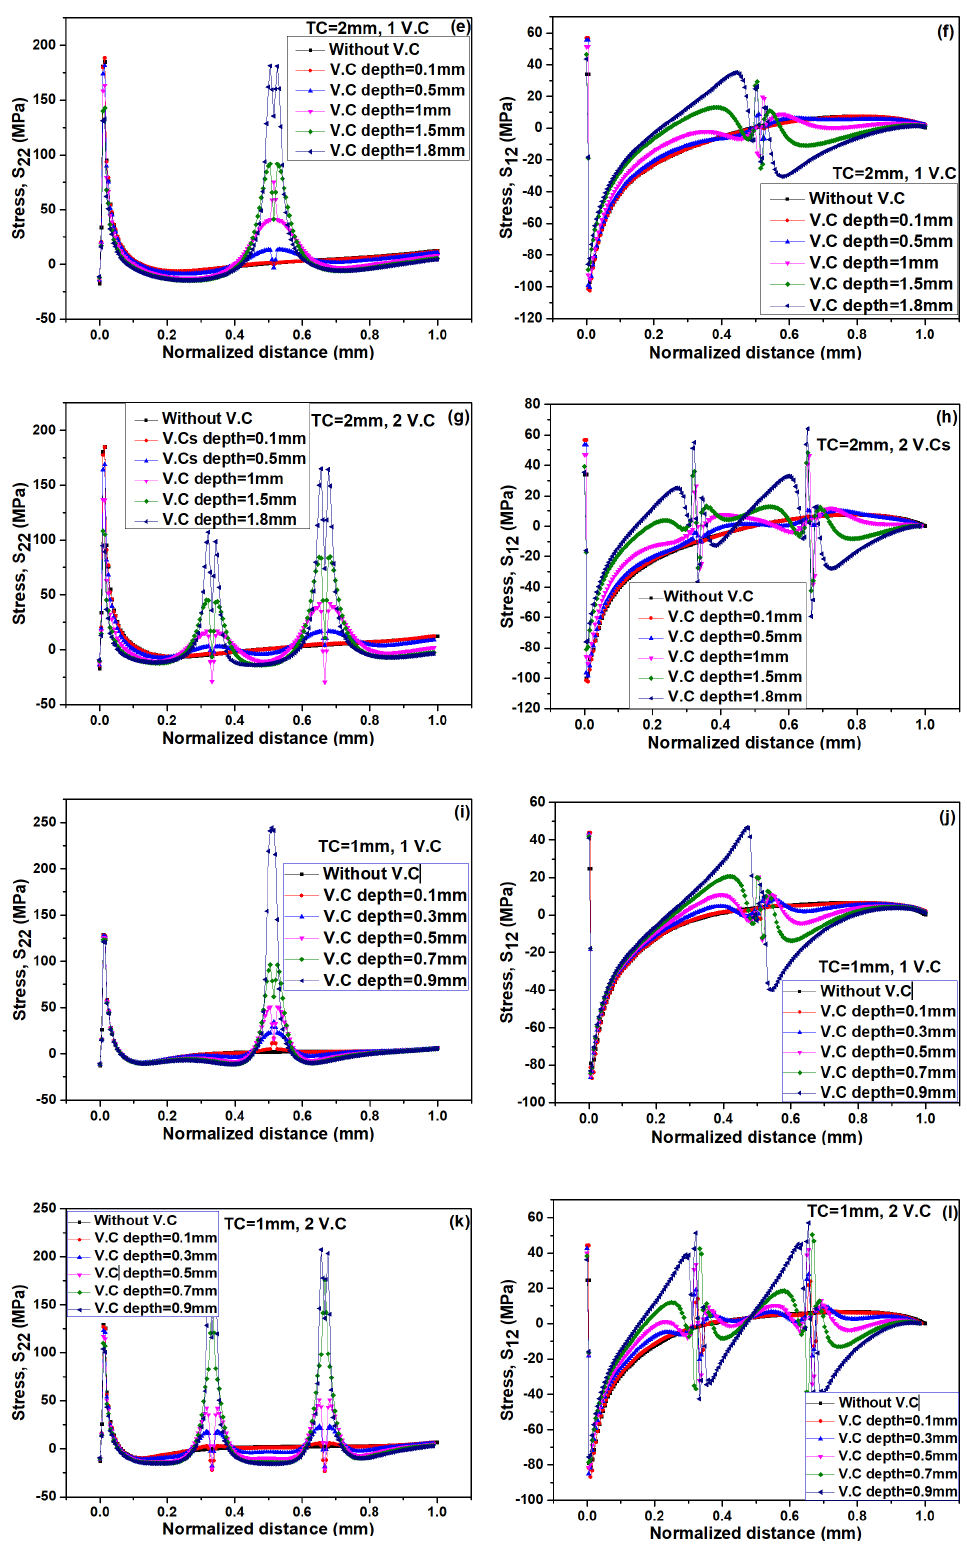
Figure 10. Stress distribution along crack line, with one and two vertical cracks in 3 mm thickness of TC ( a – d ), with one and two vertical cracks in 2 mm thickness of TC ( e – h ), with one and two vertical cracks in 1 mm thickness of TC ( i – l ).